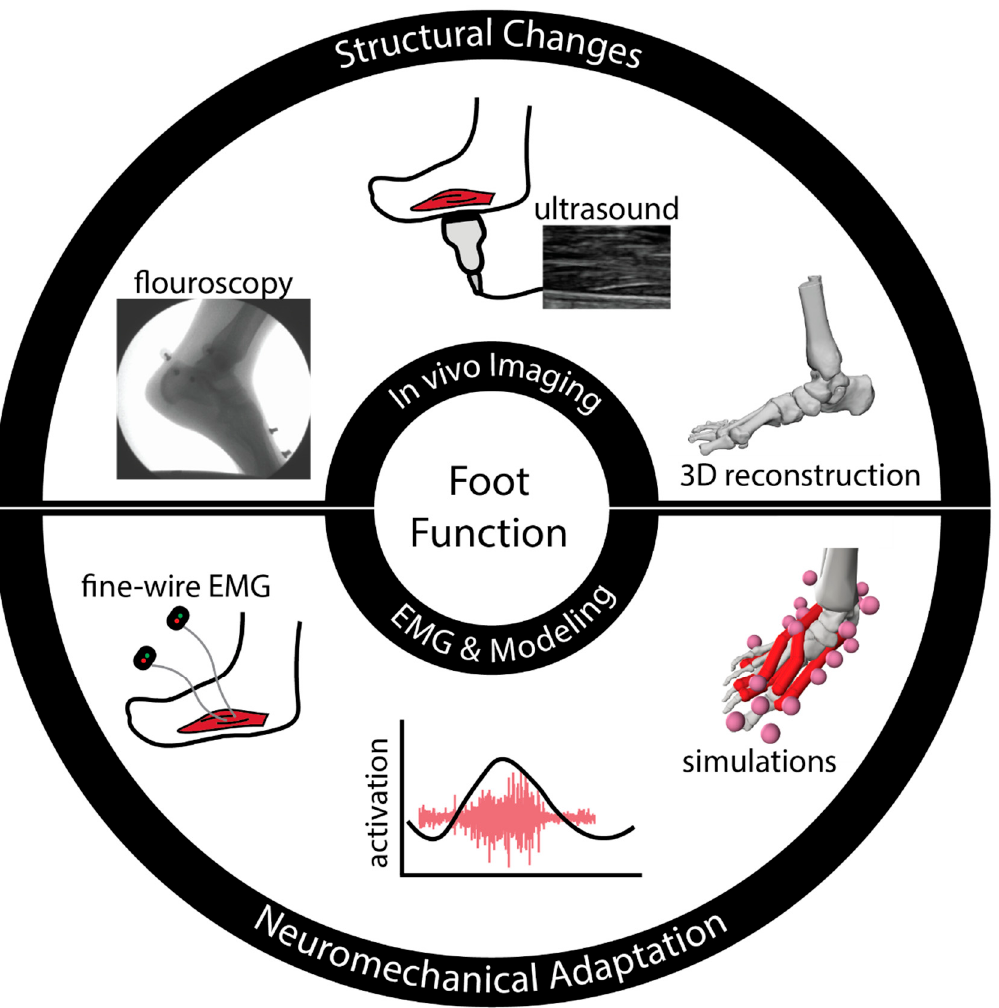
Figure 1. To gain a mechanistic understanding of the concurrent changes in foot structural and neuromechanical functions and their impact on mobility outcomes in older adults, future investigations may integrate contemporary approaches and tools that are currently transforming the field of human foot biomechanics.